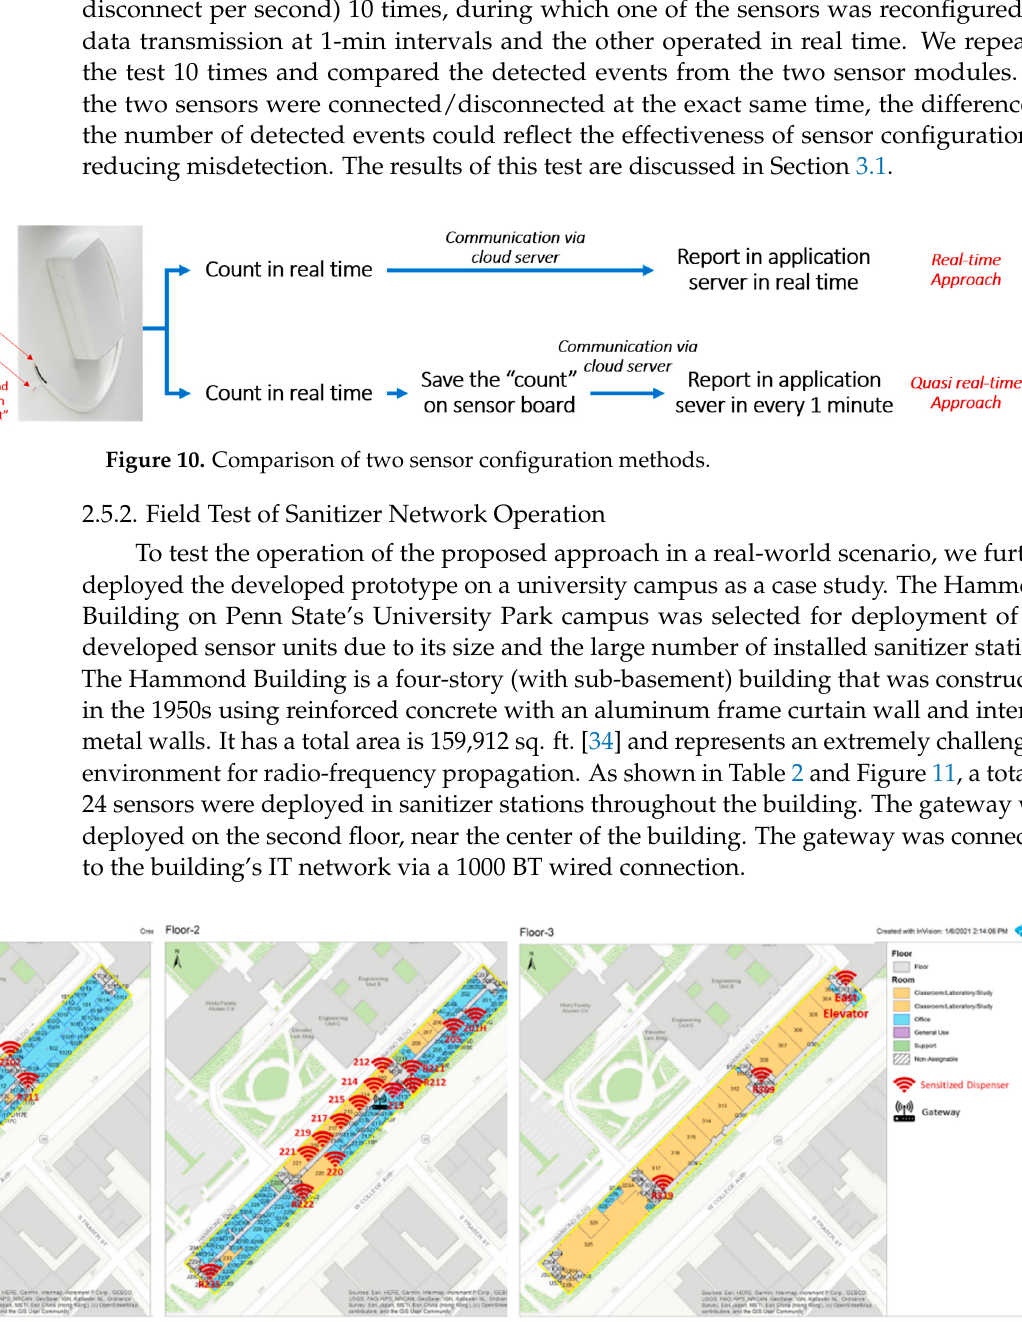
Figure 11. Building layout with sensor module deployment and gateway indicated.